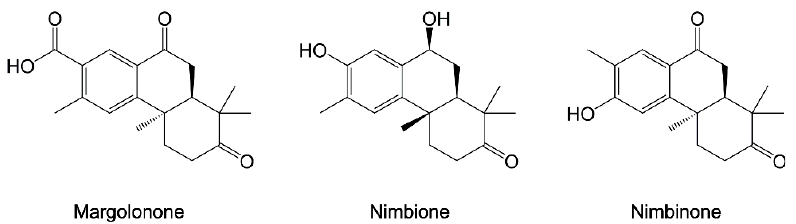
Figure 11. Chemical structures of margolonone, nimbinone, and nimbione [112].